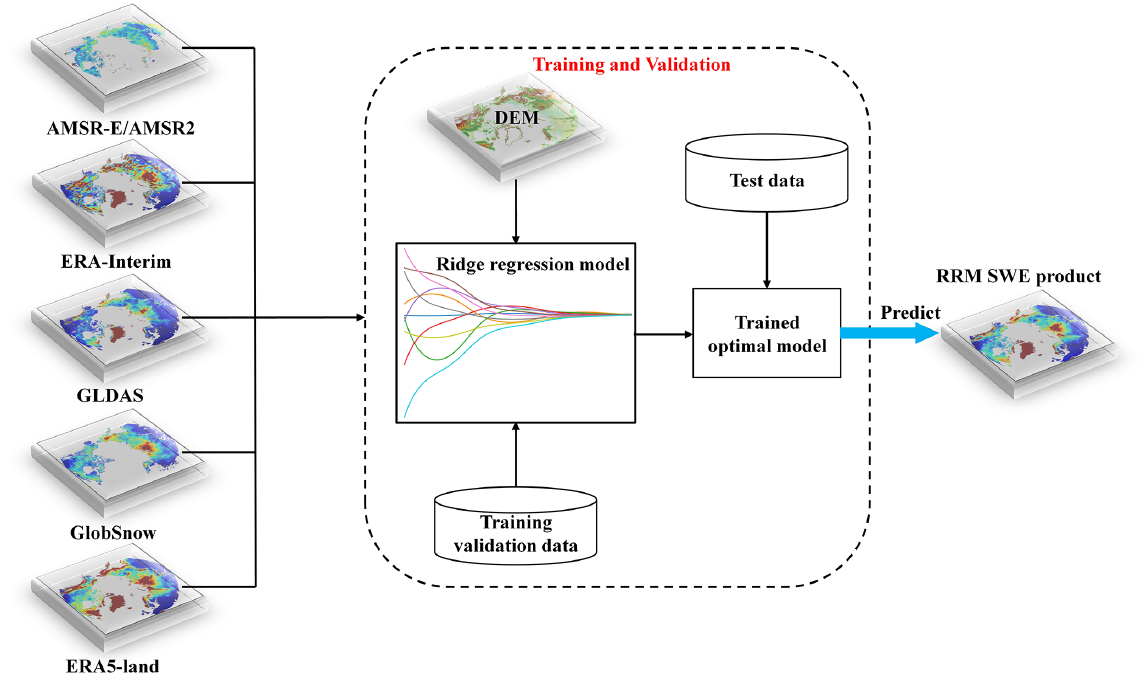
Figure 2. Flow chart of the RRM SWE data preparation (preparation of spatiotemporal seamless SWE datasets mainly includes three processes: model training, model reasoning, and SWE data